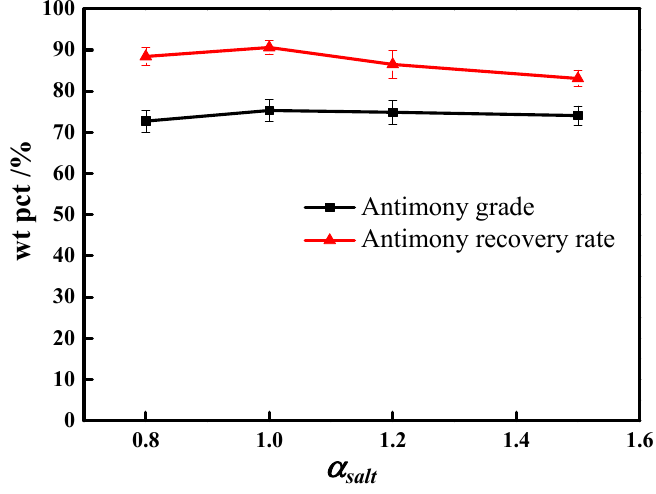
Figure 4. Influence of molten salt dosage on the recovery of antimony and antimony grade. ( W NaCl : W salt = 10%, α Fe = 1.0, W coke : W stibnite = 30%, 900 °C (1173 K), 180 min).